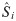
The 24 S^i’s arranged in decreasing order of their magnitudes.